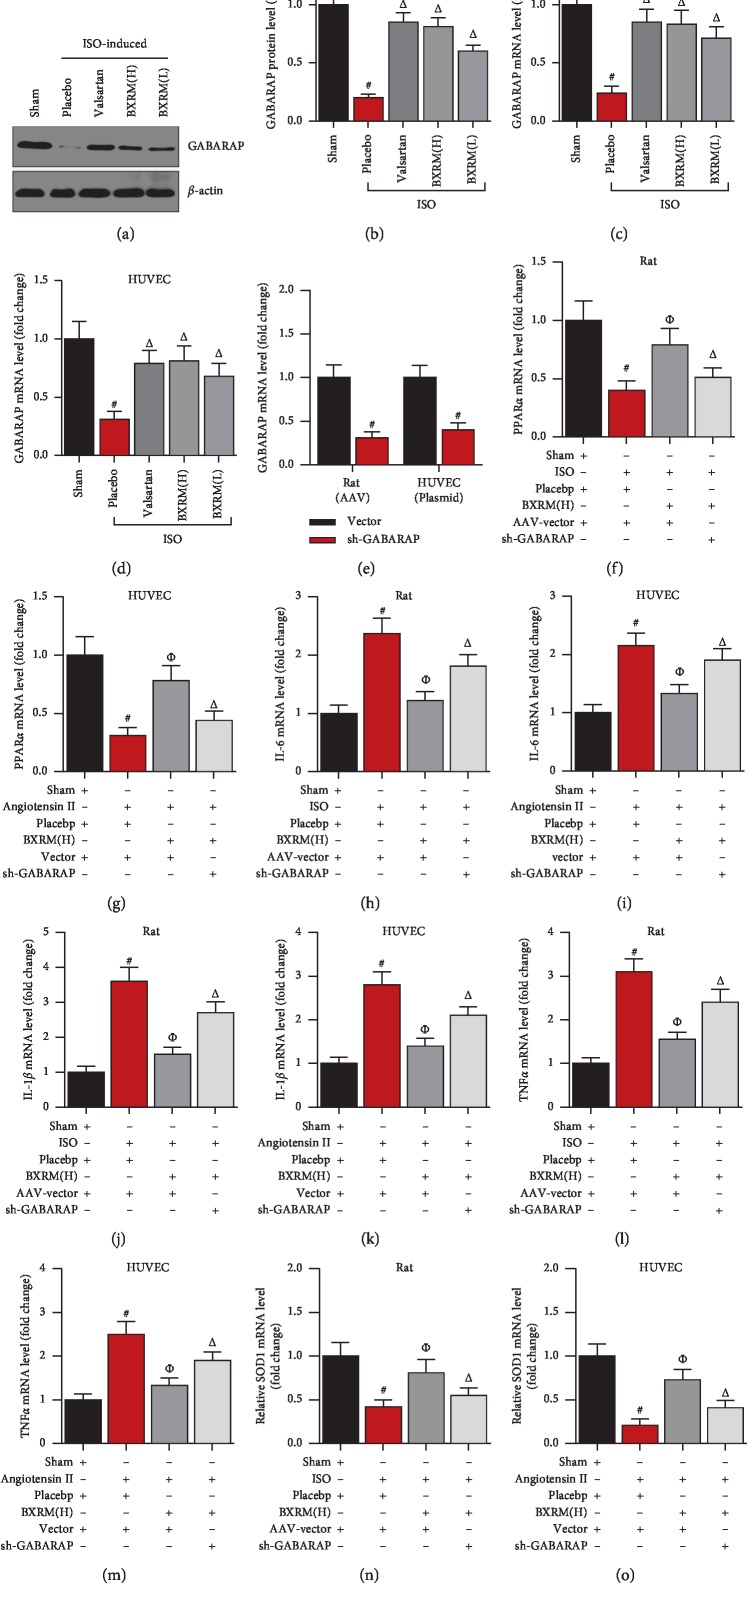
GABARAP is required for the inhibitory activity of Granule of BU-XIN RUAN-MAI on oxidation and inflammation in vivo and in vivo. (a, b) Granule of BU-XIN RUAN-MAI increased the GABARAP protein expression in heart tissues of ISO-induced rats; #P < 0.001 versus the sham group and ΔP < 0.05 versus the model group. (c) Granule of BU-XIN RUAN-MAI increased the GABARAP mRNA expression in heart tissues of ISO-induced rats after administration with Granule of BU-XIN RUAN-MAI for 6 days; #P < 0.001 versus the sham group and ΔP < 0.05 versus the model group. (d) Granule of BU-XIN RUAN-MAI increased the GABARAP mRNA expression in angiotensin II-induced HUVEC; #P < 0.001 versus the sham group and ΔP < 0.05 versus the placebo group. (e) Real-time PCR analysis of the GABARAP expression in rat heart and HUVEC cells after knockdown of GABARAP for 48 h; #P < 0.001 versus the AAV-vector group or vector plasmid. (f) Real-time PCR analysis of PPARα expression in rat heart after injection of adeno-associated virus followed by administration with Granule of BU-XIN RUAN-MAI for 6 days; #P < 0.001 versus the sham + placebo + AAV-vector and ΔP < 0.05 versus the ISO + placebo + AAV-vector. (g) Real-time PCR analysis of PPARα expression in HUVEC after transfection for 48 h followed by Granule of BU-XIN RUAN-MAI incubation for 24 h; #P < 0.001 versus the sham + placebo + vector, and ΔP < 0.05 versus the angiotensin II + placebo + vector. (h) Real-time PCR analysis of IL-6 expression in rat heart after injection of adeno-associated virus followed by administration with Granule of BU-XIN RUAN-MAI for 6 days; #P < 0.001 versus the sham + placebo + AAV-vector and ΔP < 0.05 versus the ISO + placebo + AAV-vector. (i) Real-time PCR analysis of IL-6 expression in HUVEC after transfection for 48 h followed by Granule of BU-XIN RUAN-MAI incubation for 24 h; #P < 0.001 versus the sham + placebo + vector and ΔP < 0.05 versus the angiotensin II + placebo + vector. (j) Real-time PCR analysis of IL-1β expression in rat heart after injection of adeno-associated virus followed by administration with Granule of BU-XIN RUAN-MAI for 6 days; #P < 0.001 versus the sham + placebo + AAV-vector and ΔP < 0.05 versus the ISO + placebo + AAV-vector. (k) Real-time PCR analysis of IL-1β expression in HUVEC after transfection for 48 h followed by Granule of BU-XIN RUAN-MAI incubation for 24 h; #P < 0.001 versus the sham + placebo + vector and ΔP < 0.05 versus the angiotensin II + placebo + vector. (l) Real-time PCR analysis of TNFα expression in rat heart after injection of adeno-associated virus followed by administration with Granule of BU-XIN RUAN-MAI for 6 days; #P < 0.001 versus the sham + placebo + AAV-vector and ΔP < 0.05 versus the ISO + placebo + AAV-vector. (m) Real-time PCR analysis of TNFα expression in HUVEC after transfection for 48 h followed by Granule of BU-XIN RUAN-MAI incubation for 24 h; #P < 0.001 versus the sham + placebo + vector and ΔP < 0.05 versus the angiotensin II + placebo + vector. (n) Real-time PCR analysis of SOD1 expression in rat heart after injection of adeno-associated virus followed by administration with Granule of BU-XIN RUAN-MAI for 6 days; #P < 0.001 versus the sham + placebo + AAV-vector and ΔP < 0.05 versus the ISO + placebo + AAV-vector. (o) Real-time PCR analysis of SOD1 expression in HUVEC after transfection for 48 h followed by Granule of BU-XIN RUAN-MAI incubation for 24 h; #P < 0.001 versus the sham + placebo + vector and ΔP < 0.05 versus the angiotensin II + placebo + vector. The data are representative of three independent experiments.